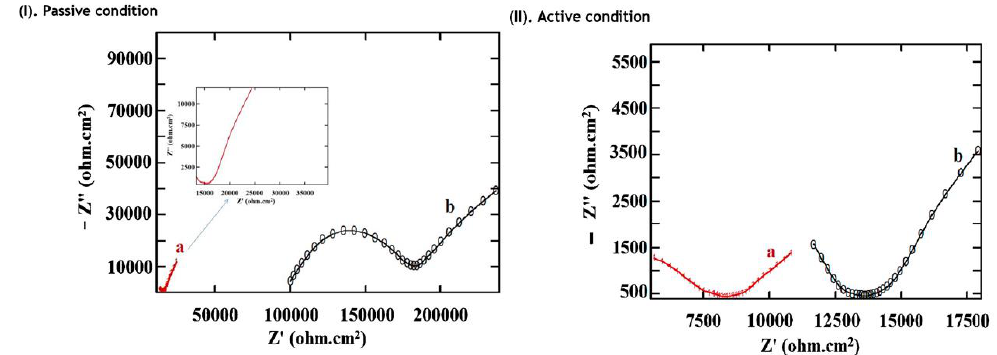
Figure 7. Nyquist plots for steel reinforcement under the active and passive condition in a concrete cube ( a ) embedded sensor and ( b ) surface mounted electrode. Reproduced with permission from ref. [107]. Copyright 2014